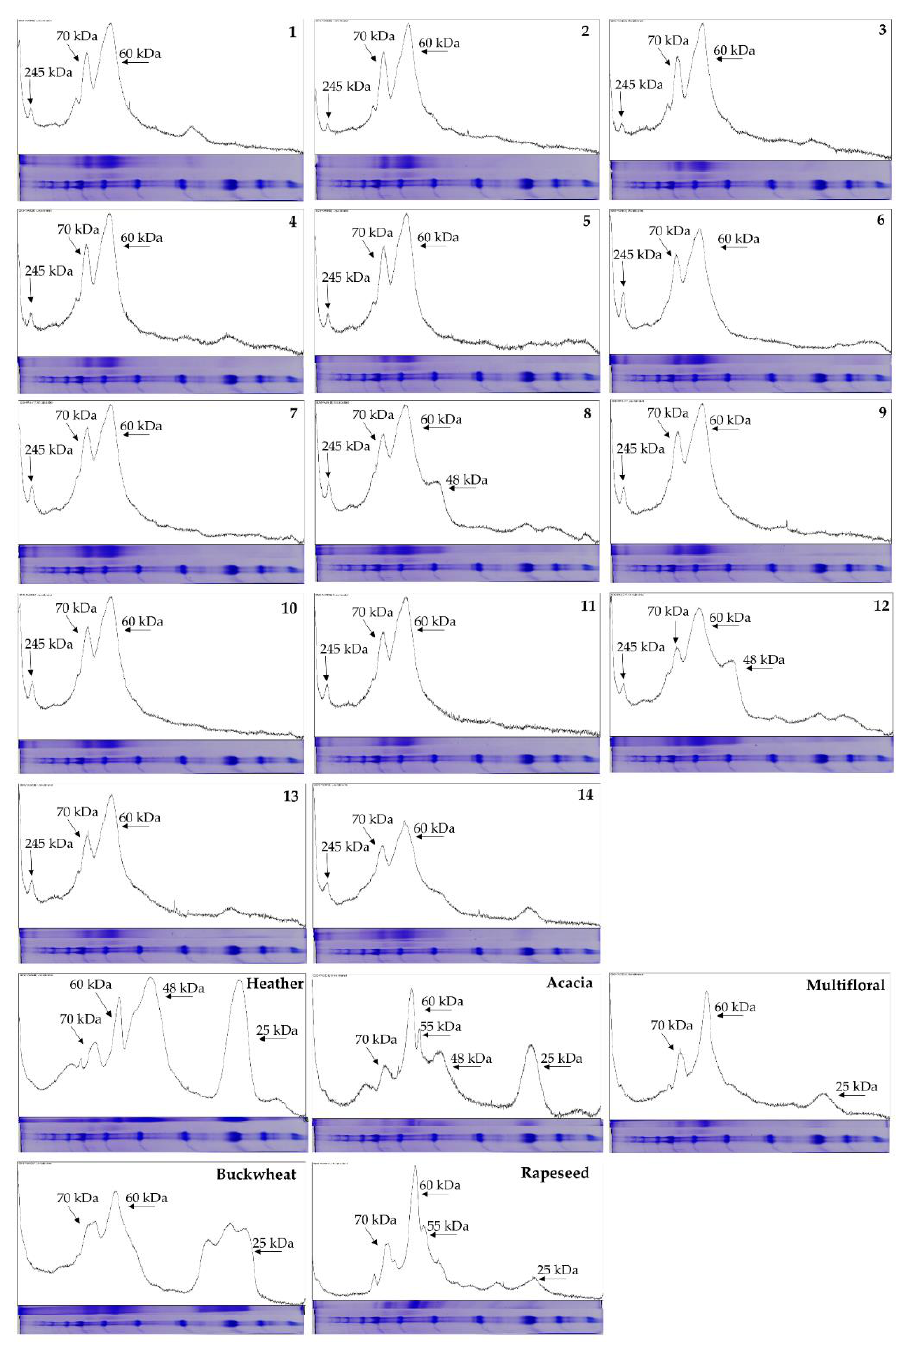
Figure 5. Detailed qualitative analysis of particular SDS-PAGE gel lanes obtained for honeydew honey samples (1 – 14) and nectar honeys in ImageJ software.